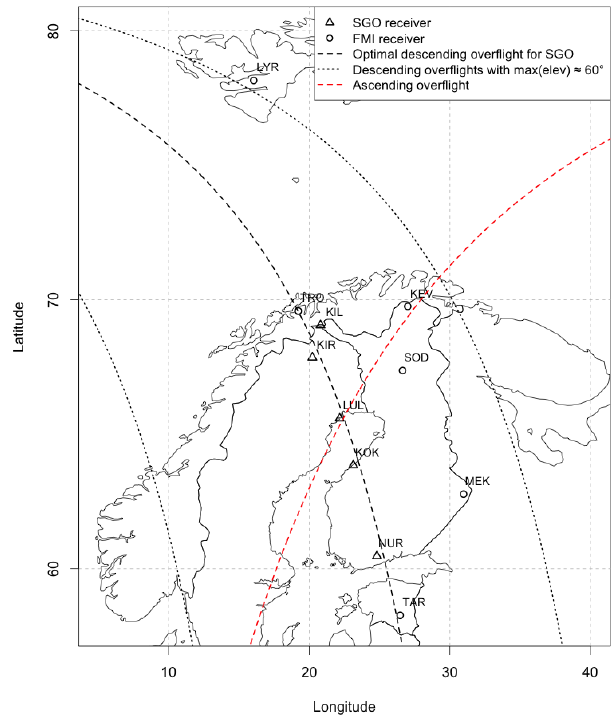
Figure 1. Current locations of SGO and FMI tomography